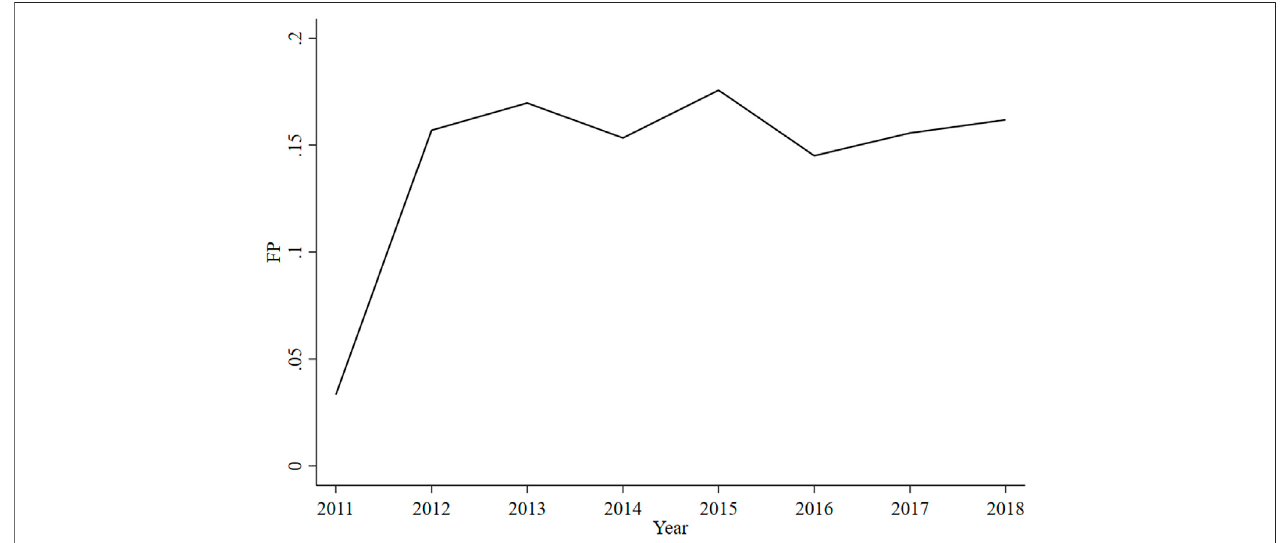
FIGURE 2 | The trend of provincial average fl oating population from 2011 to 2018 Source: the primary data collected from China National Bureau of Statistics.